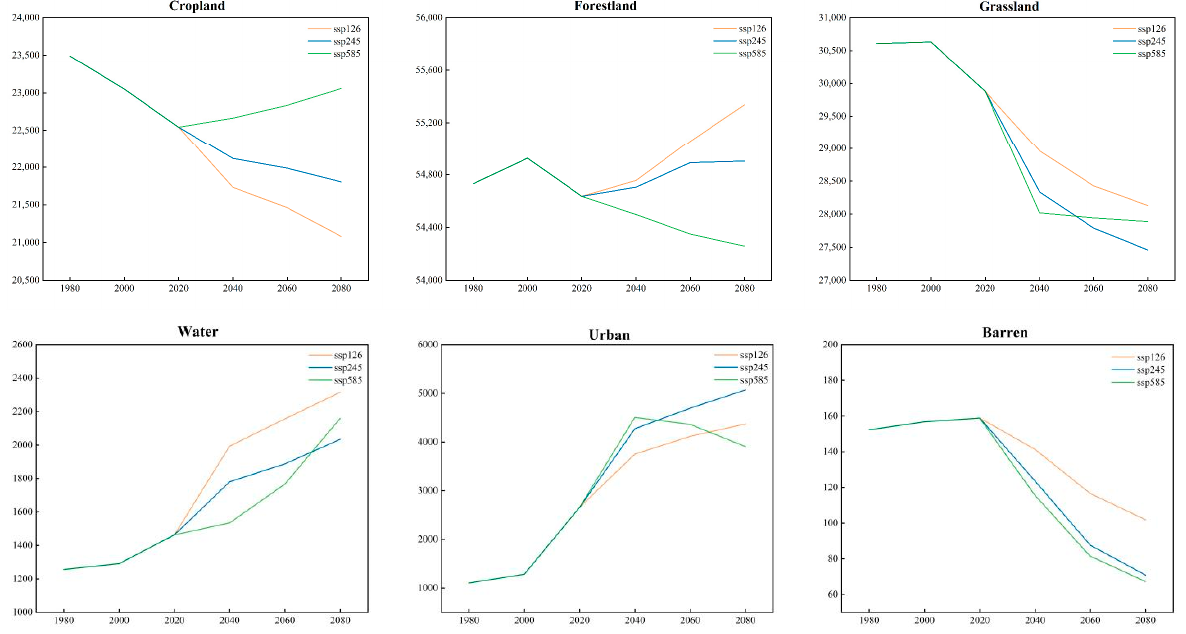
Figure 4. The number of local classes under different historical and future scenarios (unit:km 2 ).